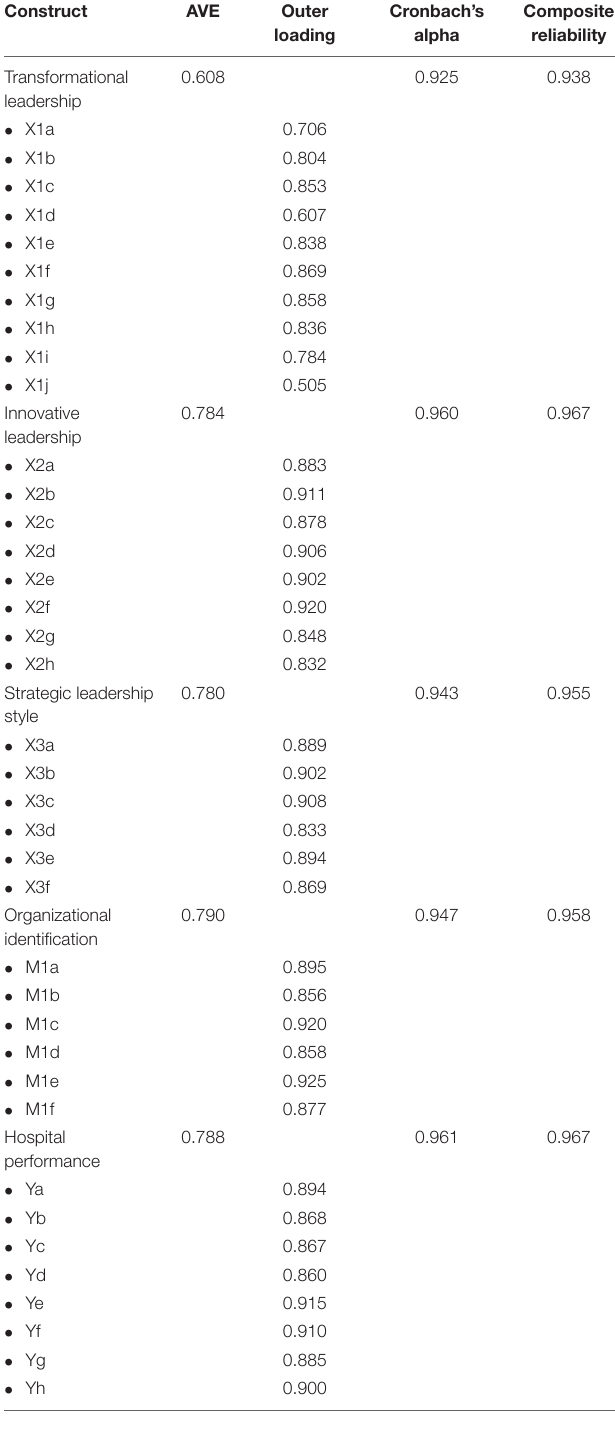
TABLE 2 | Validity and